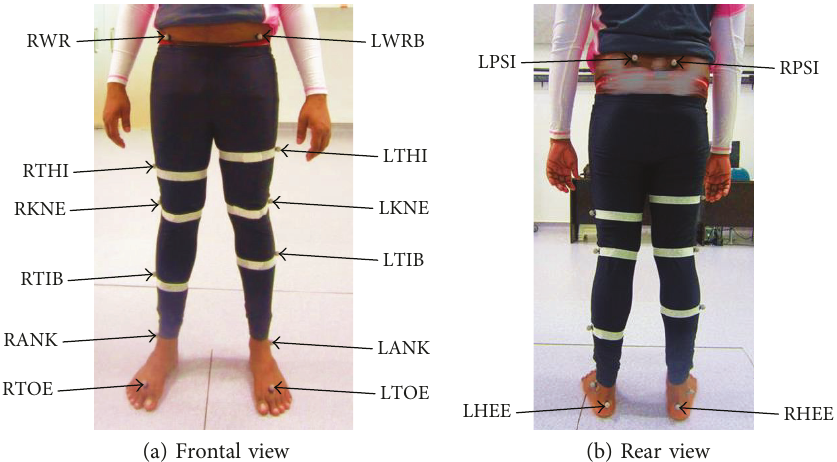
Figure 4: Marker positions on the lower limb of a healthy individual in gait analysis.